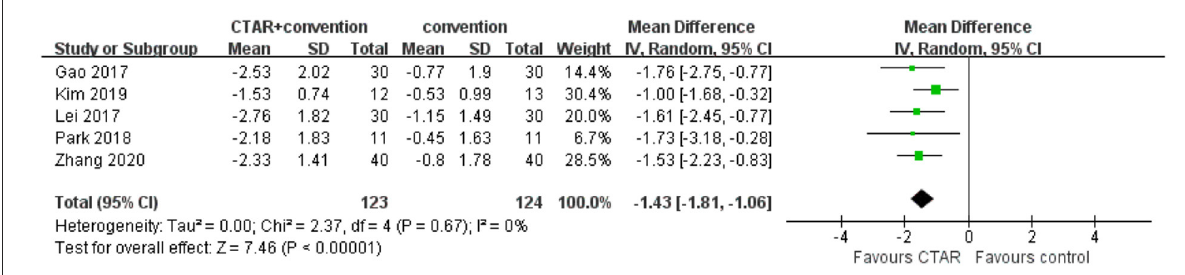
FIGURE3 Pooled changes of swallowing safety in CTAR exercise vs. no exercise intervention.